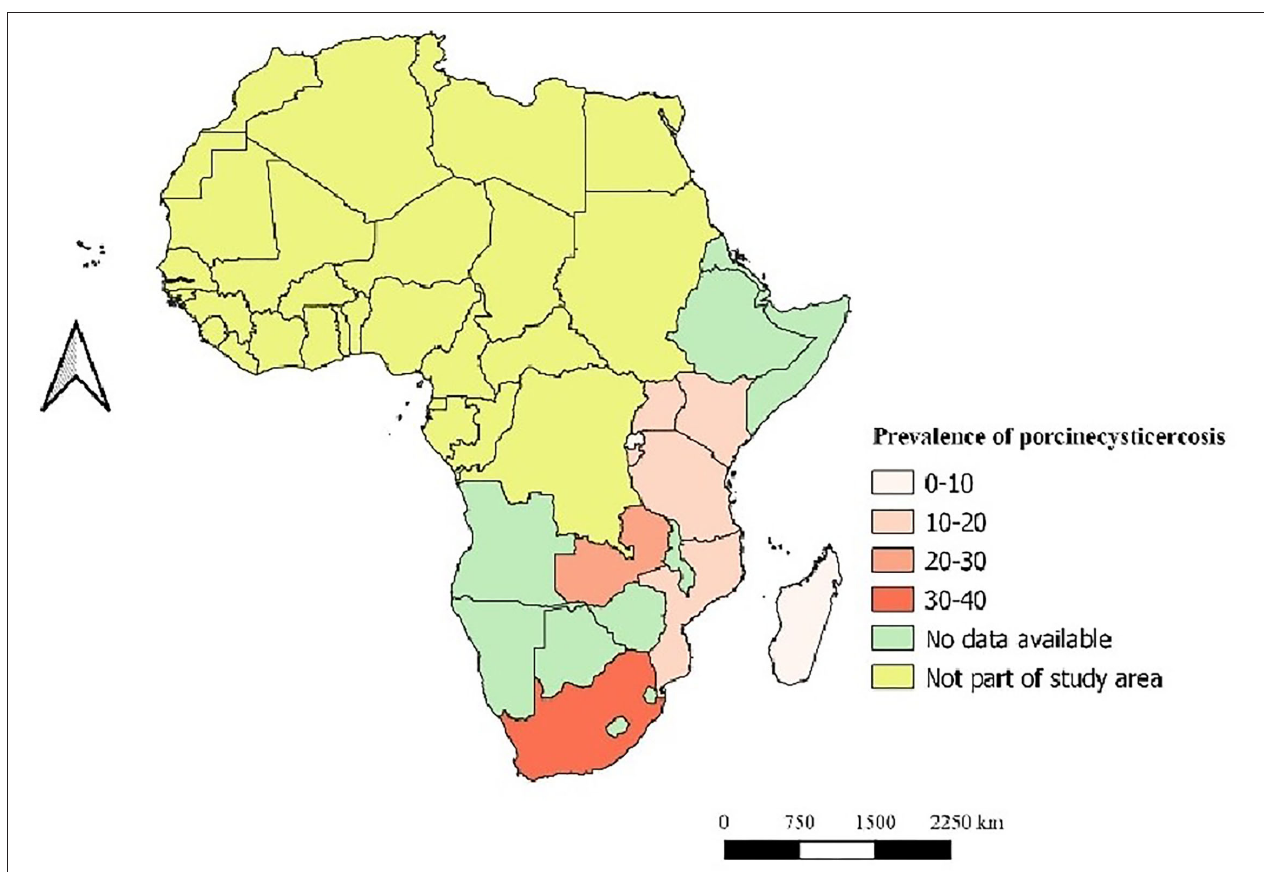
FIGURE 3 | The distribution of porcine cysticercosis in the Eastern and Southern Africa (ESA) region based on the reviewed studies.